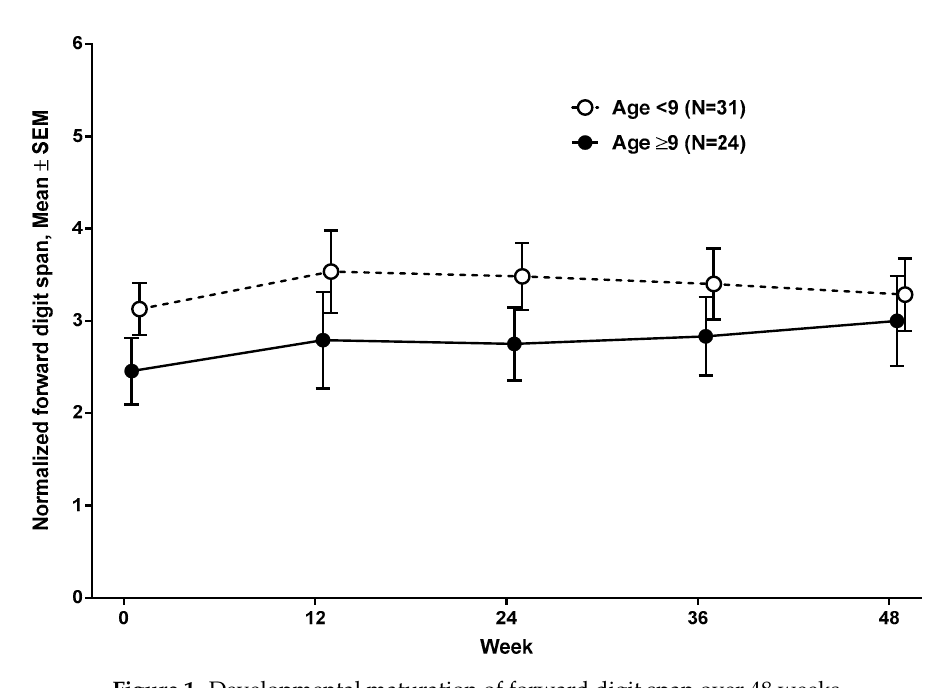
Figure 1. Developmental maturation of forward digit span over 48 weeks.